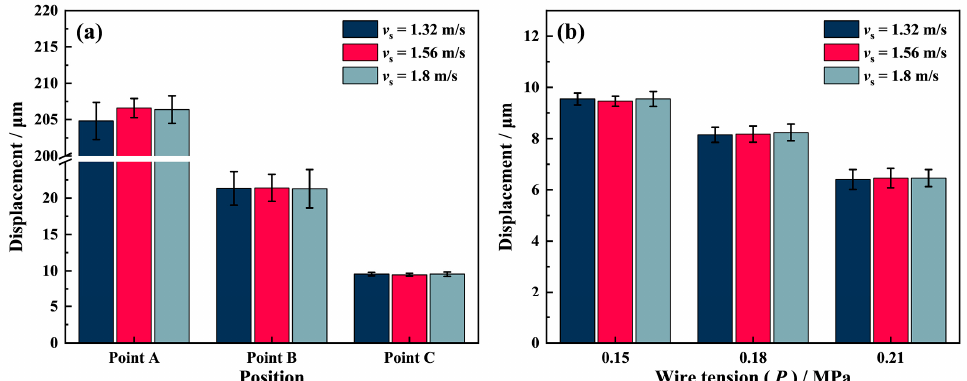
Figure 7. ( a ) The lateral displacement of the diamond wire at different points; ( b ) the lateral displacement of the diamond wire at point C under different wire tension conditions.